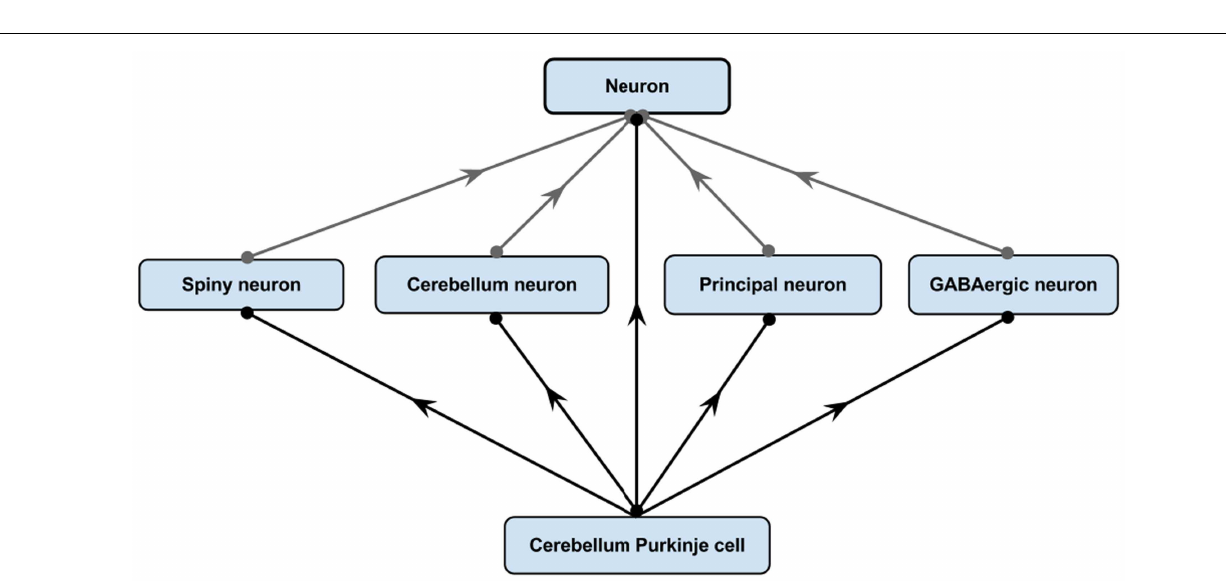
FIGURE 6 |After invoking a reasoner NIFSTD Cerebellum Purkinje cell becomes a subclass of four different defined neuron types based on the restrictions specified in Figure